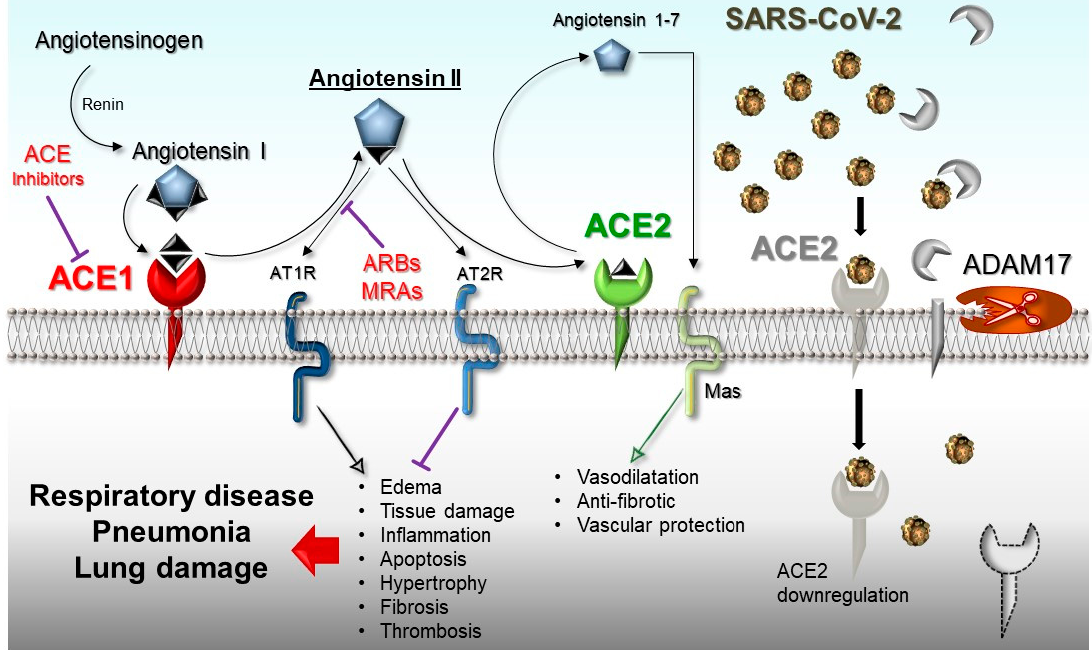
Figure 1. Schematic representation of the renin – angiotensin system (RAS)-pathway in which ACE1 / Ang-II / AT1R-axis and ACE2 / Ang 1-7 / Mas-axis are shown. On the right of the panel, the SARS-CoV-2-mediated suppression of the ACE2 receptor and the cleavage activity of ADAM17 on ACE2 are shown. ADAM17: Metallopeptidase domain 17; ARBs: Angiotensin receptor blockers; MRAs: mineralocorticoid receptor antagonists.